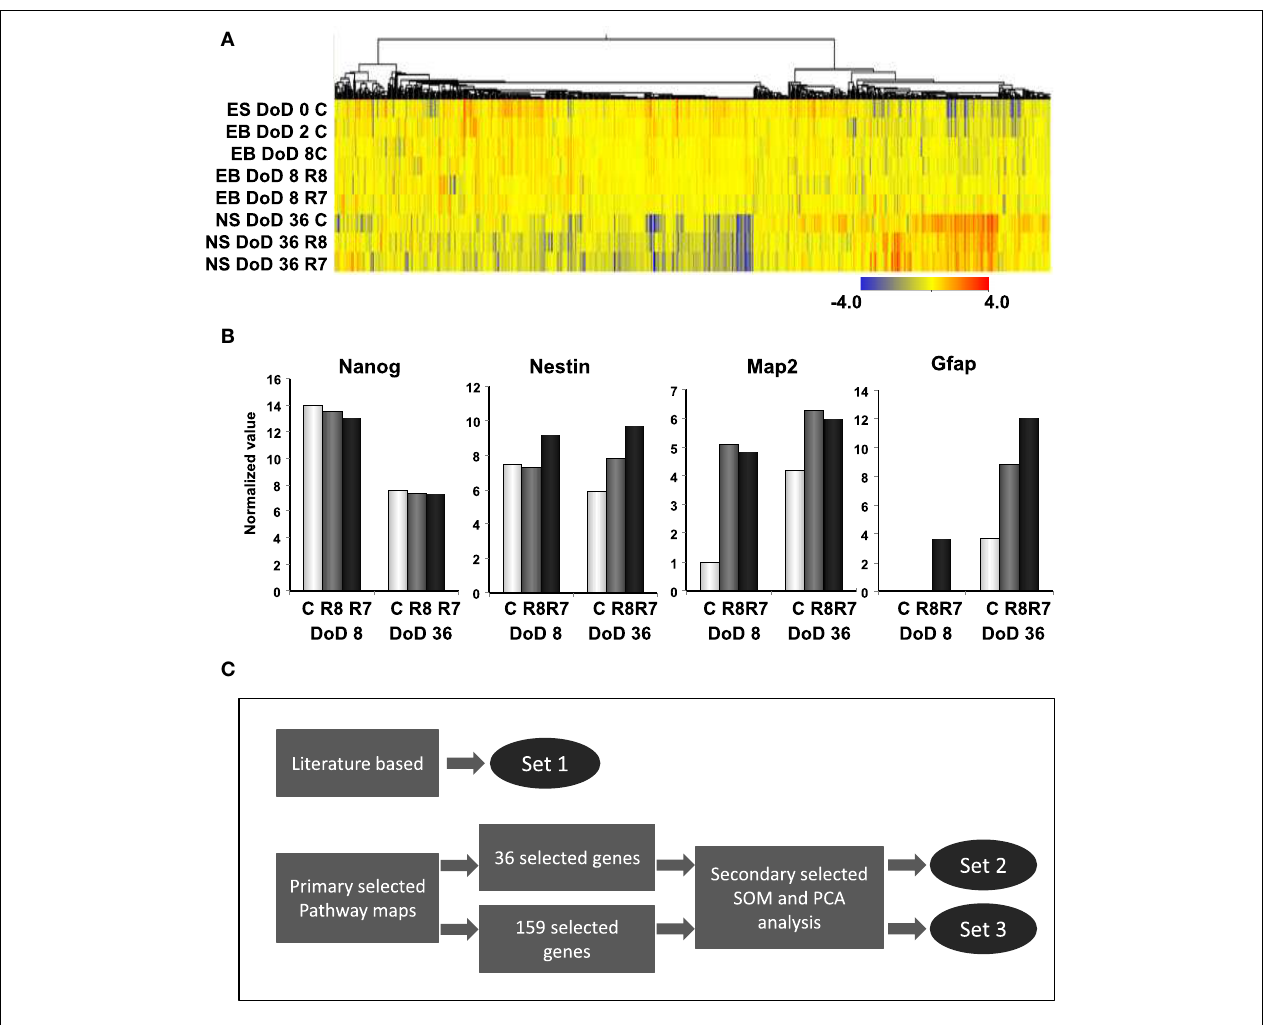
in DNA microarray. Symbols of C, R8, and R7 indicate vehicle control, RA 10 − 8 M, and RA 10 − 7 M. (C) Stage-specific gene expression signatures in response to RA during the neural differentiation of mESCs were identified as follows: set 1 was a set of genes selected from the literature; set 2 was selected by SOM and PCA after selecting 36 genes from pathway maps; set 3 was selected by SOM and PCA after selecting 159 genes from pathway maps. Expression values of microarray data corresponding to genes in these three sets were used for the Bayesian network